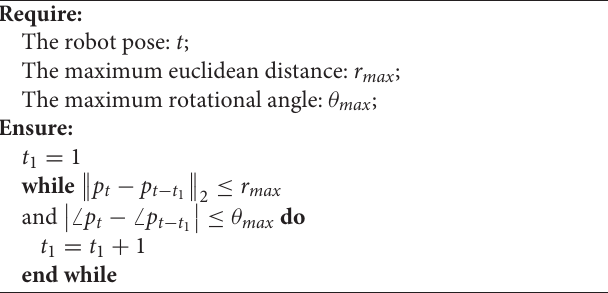
Algorithm 1: Greedy search for t 1